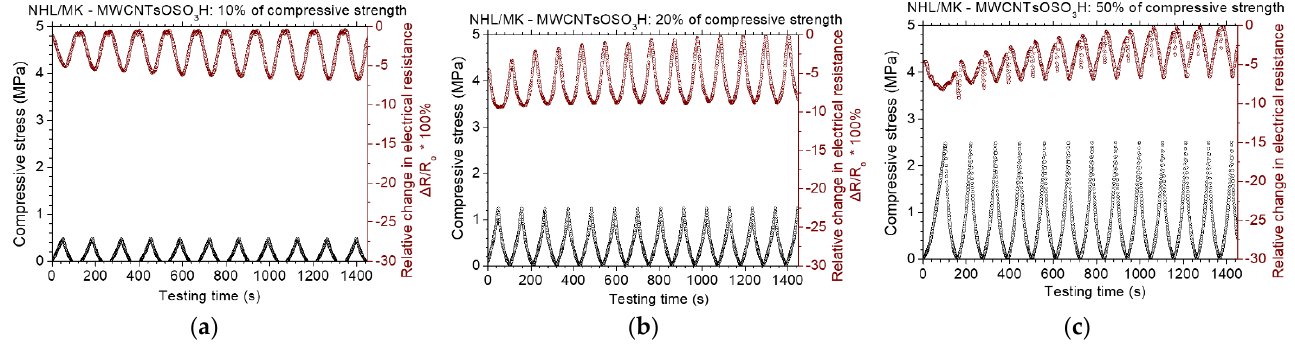
Figure 13. Cyclic, piezoresistive response of MWCNTsOSO 3 H reinforced binary paste at constant amplitude level of ( a ) 10%, ( b ) 20% and ( c ) 50% of the compressive strength of the paste.